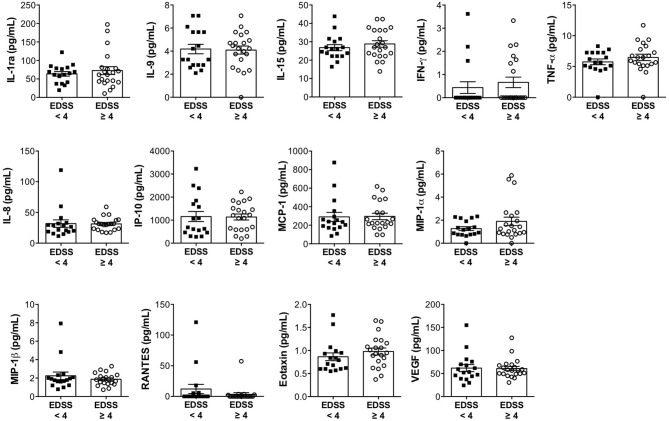
The expression levels of immune soluble factors released in the CSF of progressive MS disease are not associated with expanded disability status scale (EDSS). The levels of IL-1ra, IL-9, IL-15, IFN-γ, TNF-α, IL-8, IP-10, MCP-1, MIP-1α, MIP-1β, RANTES, eotaxin, and VEGF were measured in the CSF of patients with progressive MS with minimal-to-moderate disability (EDSS < 4) or with high disability (EDSS ≥ 4), by multiplex assay. Each CSF sample was analyzed in duplicate and means are represented. Data are reported as mean ± SEM.